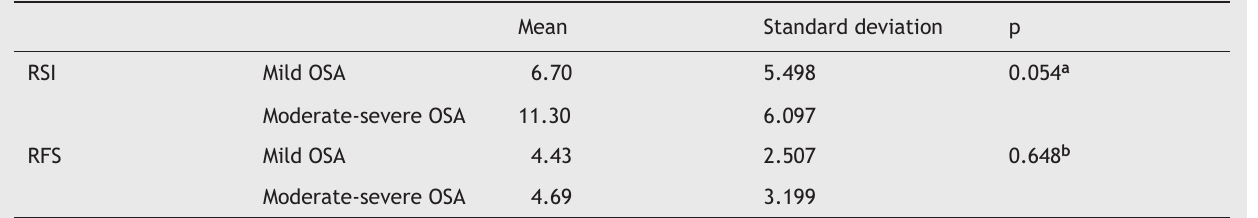
Table 3 t -test for equality of means in obese